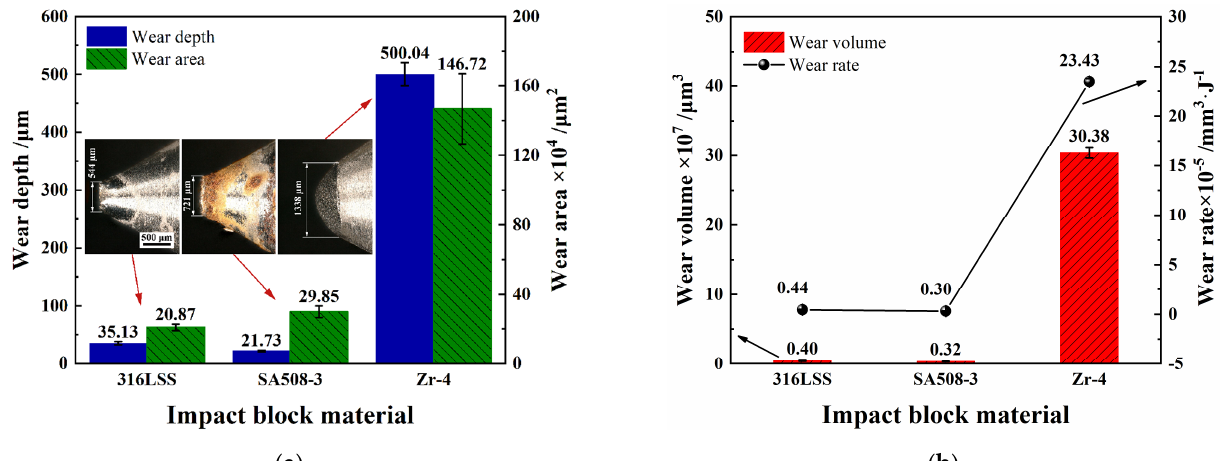
Figure 11. Wear statistics of wear scars after Zr−4 alloy tube impacted 500,000 times: ( a ) wear depth and wear area; ( b ) wear volumn and wear rate.